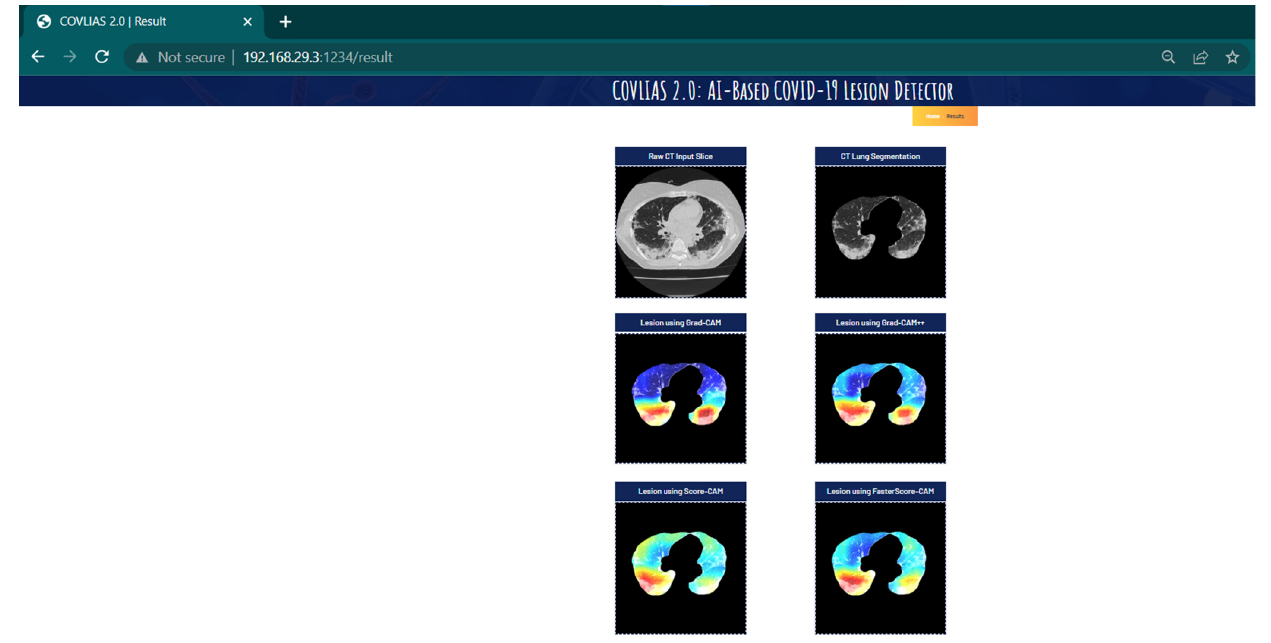
Figure 22. A web-view screenshot.